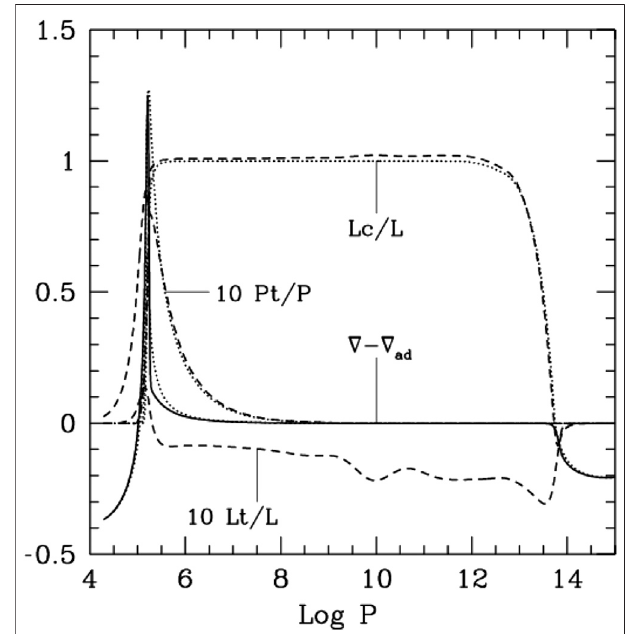
FIGURE 2 | Fractional convective fl ux L c / L , turbulent kinetic energy fl ux L t / L , super-adiabatic temperature gradient ∇ − ∇ ad , and the ratio of turbulent pressuretogaspressure P t / P vs.log P forthelocal(dotted-line)andnon-local (solid-line) convective